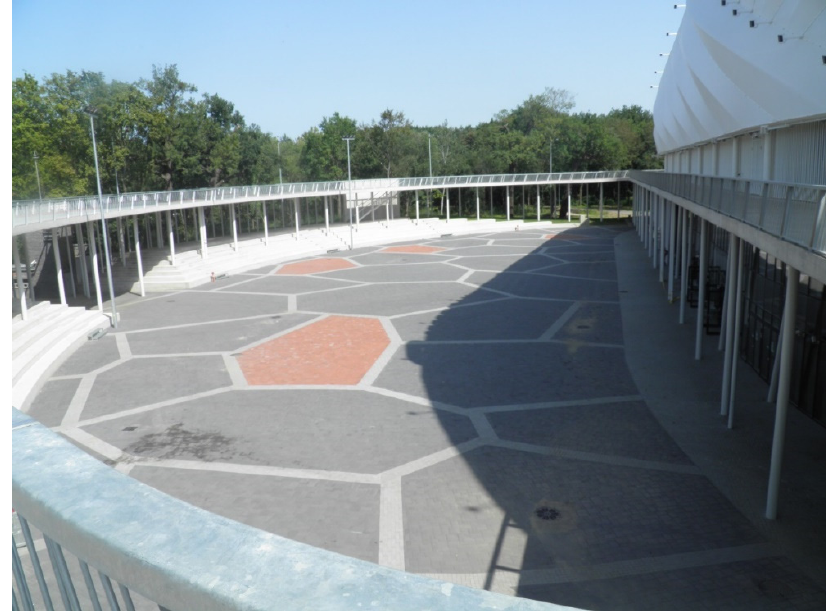
Figure 12. Event area on the northern side. Source: own collection.